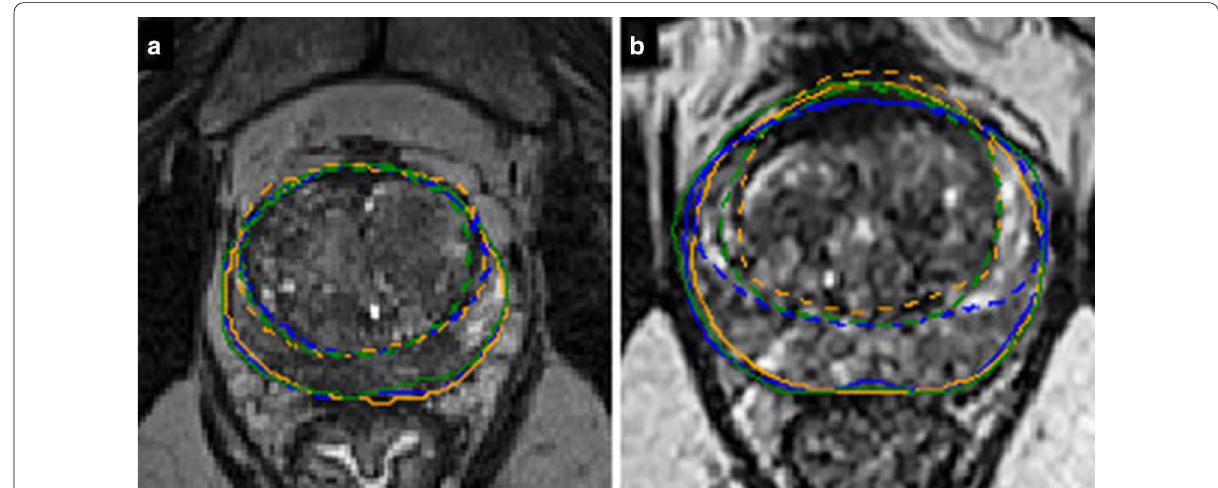
Fig. 2 Examples of low ( a ) and high ( b ) segmentation variabilities for WG (full line) and TZ (dashed line) on a transverse slice for one rater of each group of experience (blue for expert, orange for senior, green for